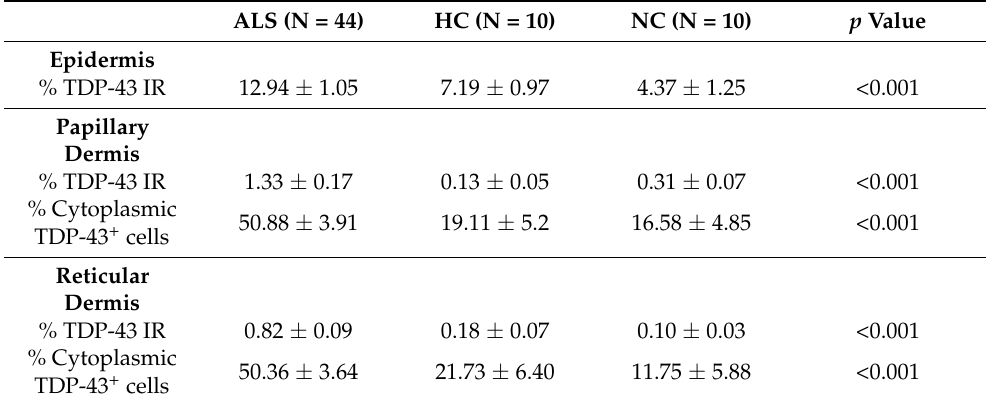
Table 1. Results of TDP-43 immunoreactivity and cells with cytoplasmic TDP-43-positive cells. Values are shown as mean and SEM. ALS: amyotrophic lateral sclerosis; HC: healthy controls; NC: neurological controls (5 multiple sclerosis and 5 Parkinson’s disease); IR: immunoreactivity.